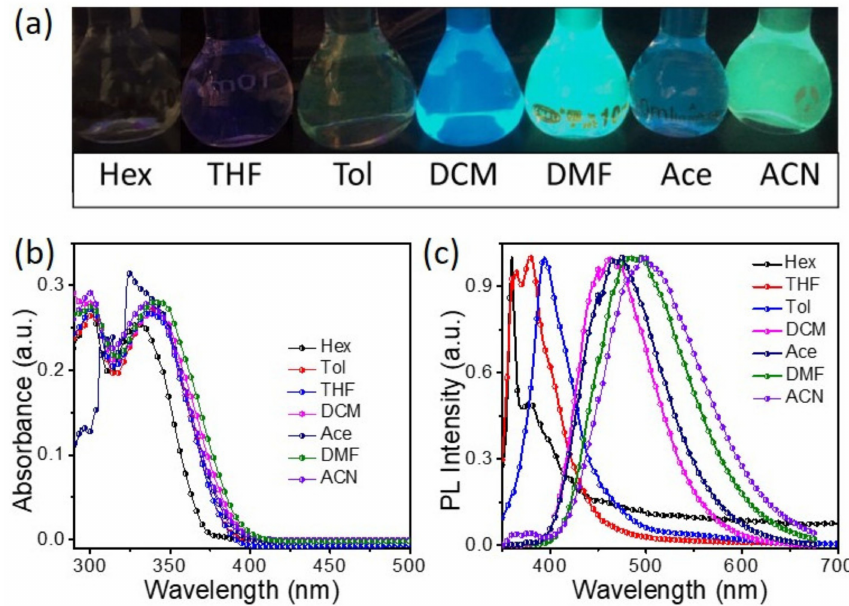
Figure 1. ( a ) Fluorescence images and ( b ) absorption and ( c ) PL spectra of BP-3-Cz in solutions with different polarities.